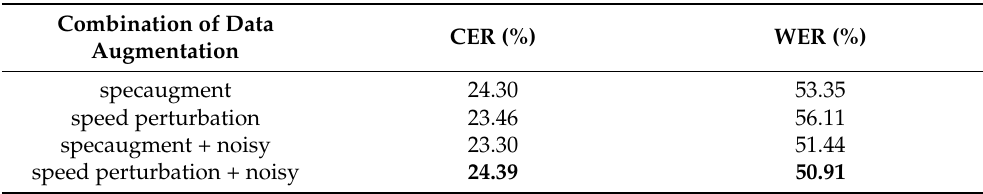
Table 7. Results of exploratory experiments with different data augmentation combinations. Here, we do not use LM. Our experimental results are highlighted in